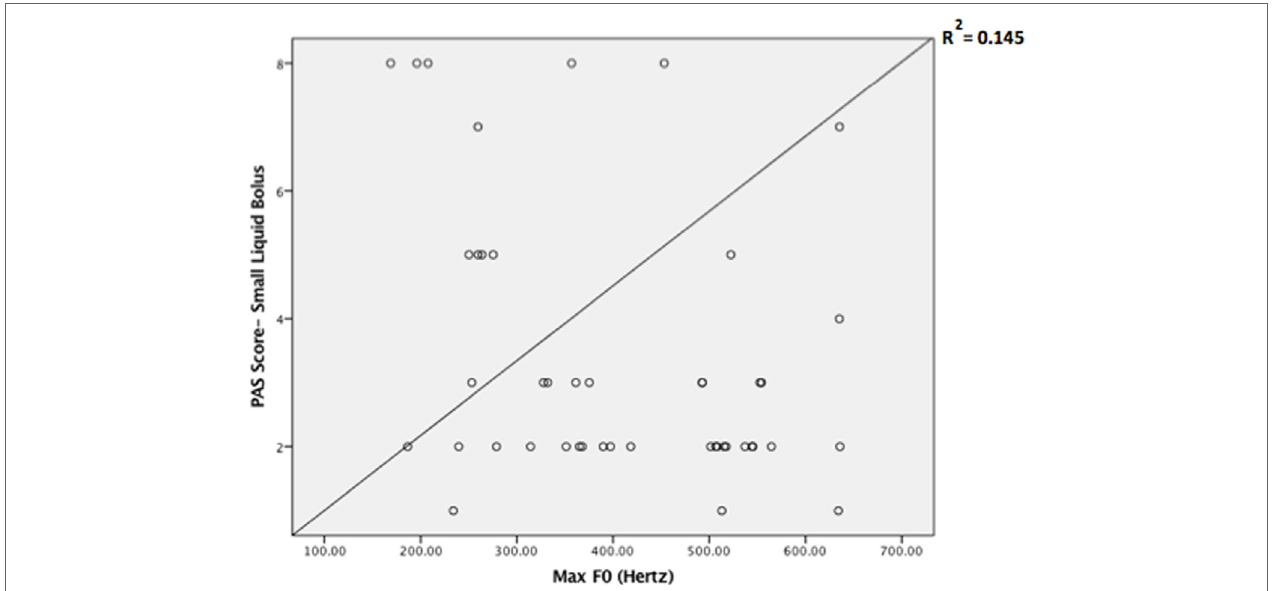
FigUre 1 | Scatter plot of the Penetration/Aspiration Scale (PAS) scores for small liquid bolus (5–10 mL) across maximum fundamental frequency (max F 0 )